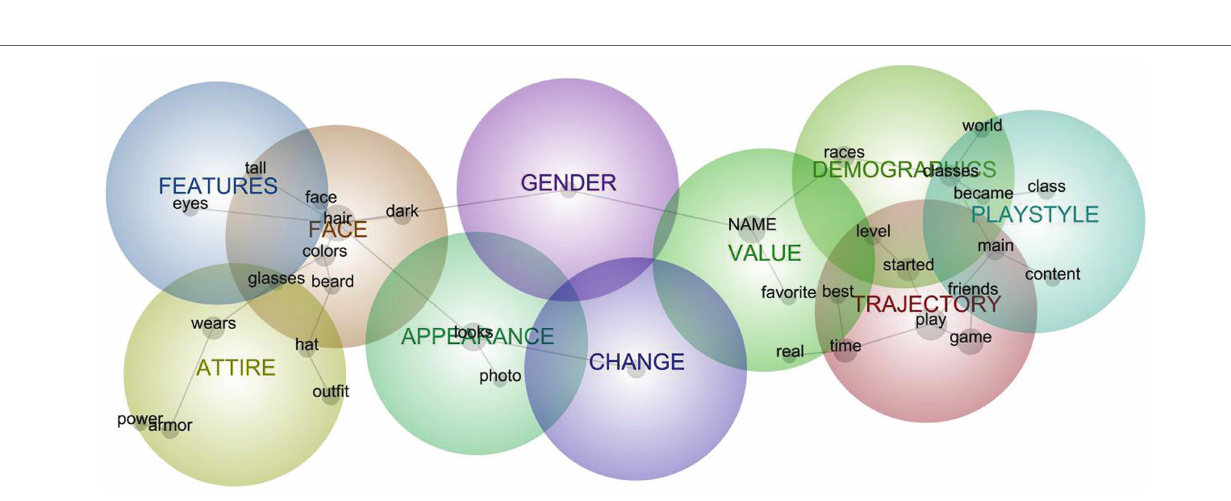
FIGURE 2 | Semantic network model for aggregated descriptions of avatars in Me